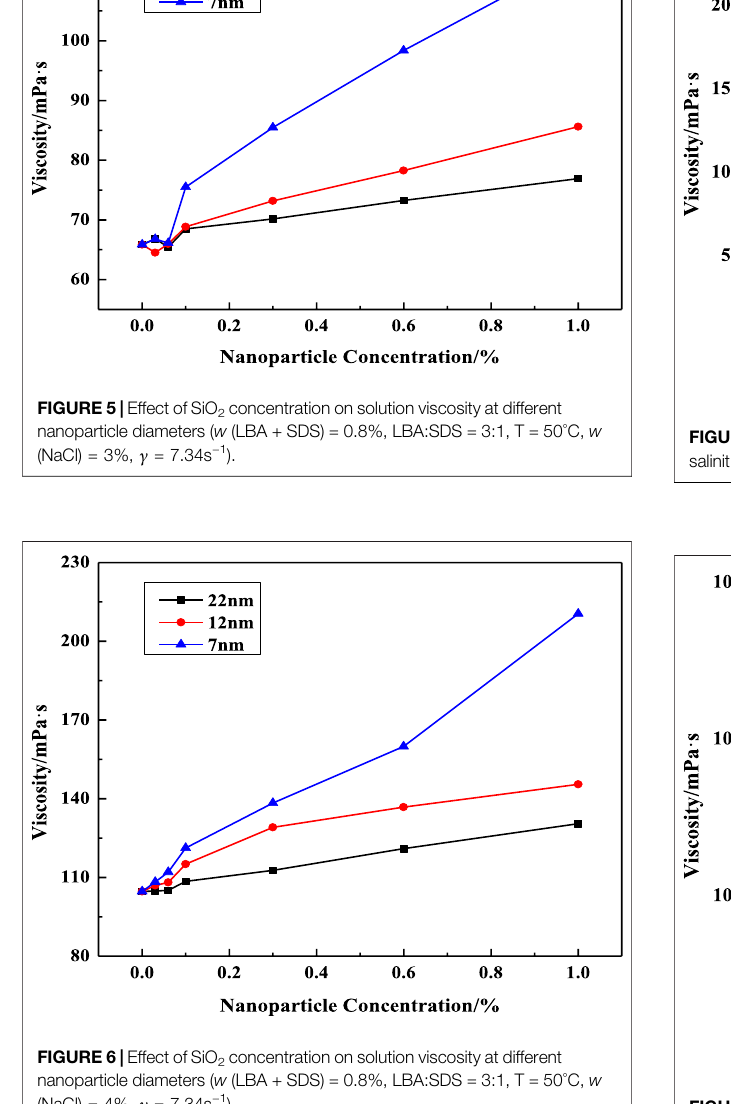
FIGURE 8 | Effect ofSiO 2 concentration on solution viscosity at different surfactant concentrations (LBA:SDS (cid:2) 3:1, T (cid:2) 50 ° C, w (NaCl) (cid:2) 4%, γ (cid:2) 7.34s − 1